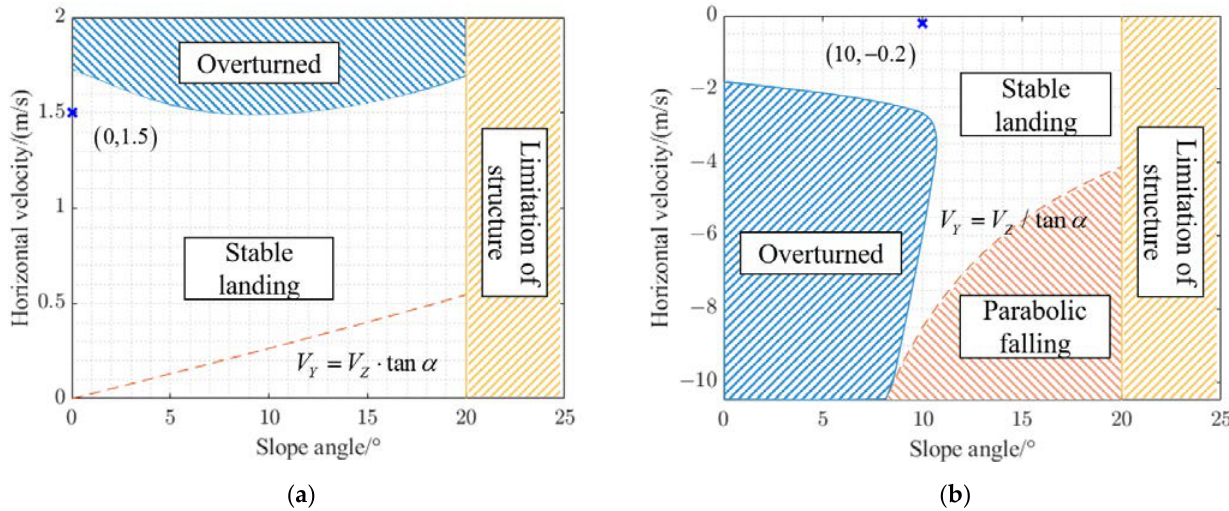
Figure 10. The landing stability boundary considering the influences of initial vertical velocity and slope angle: ( a ) represents boundary with positive velocity and slope angle varying in the range of 0–20°; ( b ) represents boundary with negative velocity and slope angle varying in the range of 0–20°. The red dashed line in Figure 10a is used to determine the direction of the